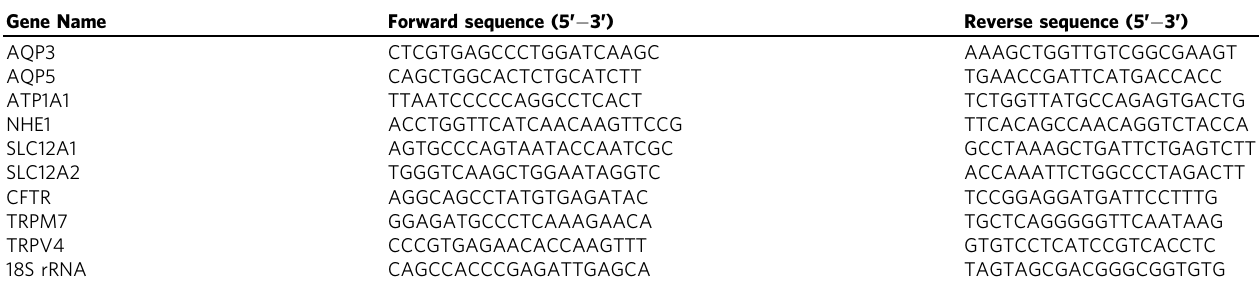
Table 1 Forward and reverse sequences of primers for the genes used for gene expression analysis in human